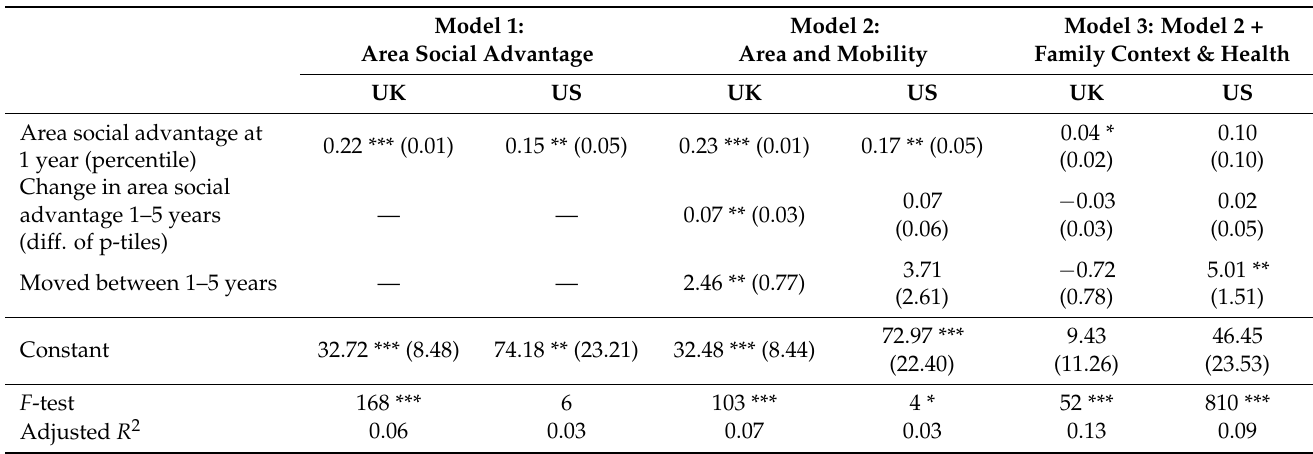
Table 3. Externalizing Behavior Adjustment at 5 years: Selected OLS Unstandardized Regressions Coefficients (Standard Error in parentheses) in UK (N = 7668) and US (N = 1820) a,b